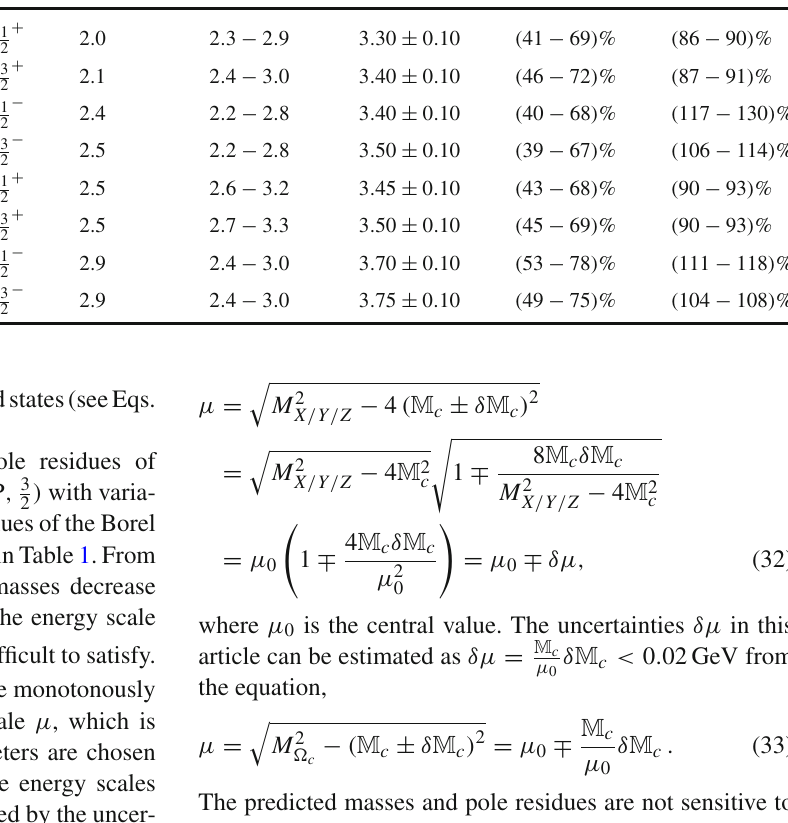
Fig. 2 The masses and pole residues of the (cid:2) c states with variations of the energy scale μ for the central values of the Borel parameters and threshold parameters shown in Table 1, where A , B , C and D correspond to (cid:2) c ( 1S , 1 Table 1 The optimal energy scales μ , Borel parameters T 2